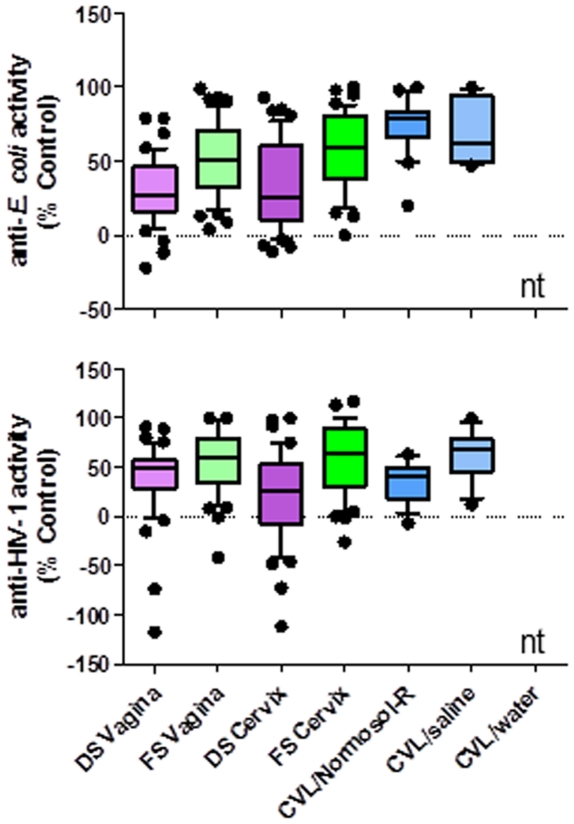
Levels of antimicrobial activity in female genital tract secretions collected by cervicovaginal lavages (CVL) and swabs.Female genital tract secretions were collected by Dacron swabs (DS) and flocked swabs (FS) from the vagina and the endocervix (cervix) and by CVL using Normosol-R, saline, or water. Anti-E. coli activity was calculated as the % inhibition of bacterial growth compared to an untreated control. Anti-HIV-1 activity was calculated as the % inhibition of infection as compared to an untreated control. CVL/water was not tested (nt) because water would lyse the pathogens or cells providing non-reportable results. Negative values reflect increased E. coli growth or enhanced HIV-1 infection. Data are presented as box and whisker plots where the median is the horizontal line through the vertical box which represents the 25–75th percentiles. Values within the 10–90th percentiles are represented by the error bars. Outliers are shown by filled circles. Significant changes were determined using linear mixed model and discussed in the results section.